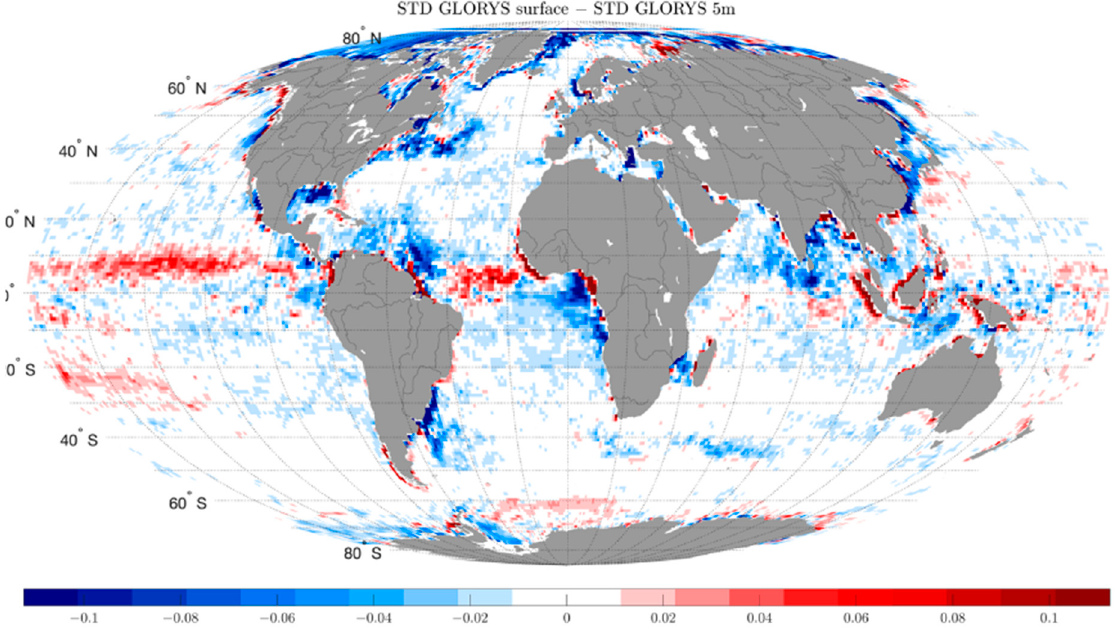
Figure 9. Difference between STD of GLORYS at surface minus STD of GLORYS at 5 m, computed over 2016–2018 period. over 2016–2018